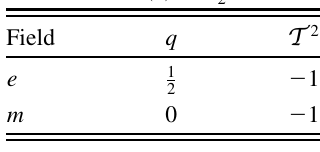
TABLE V. U ð 1 Þ (cid:1) Z T Field